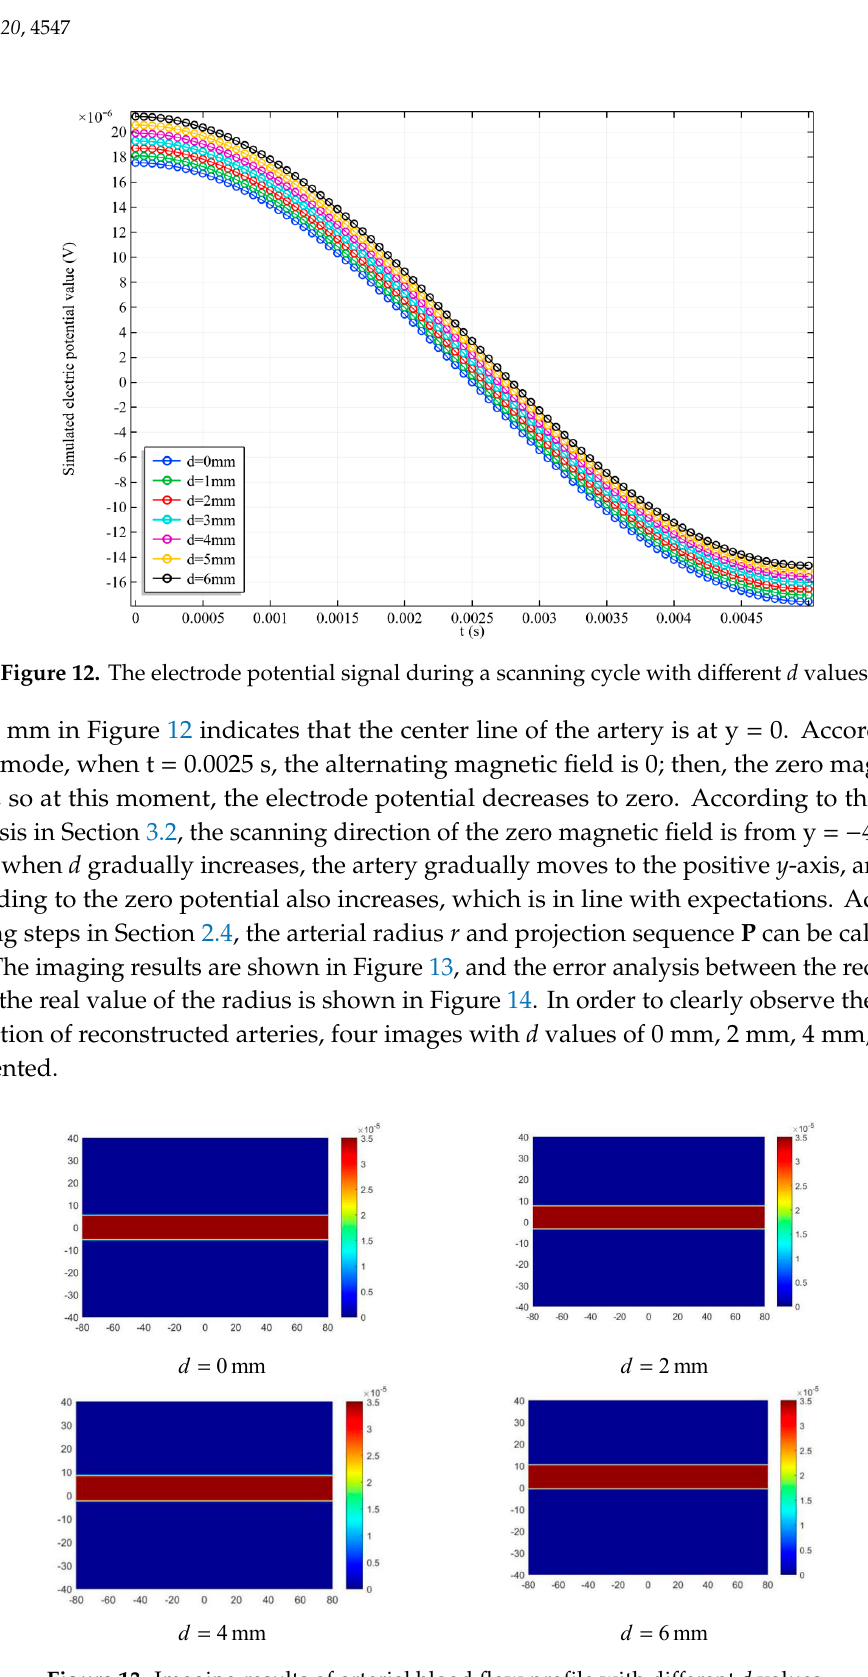
Figure 11. d represents the distance from the center of the artery to y = 0.